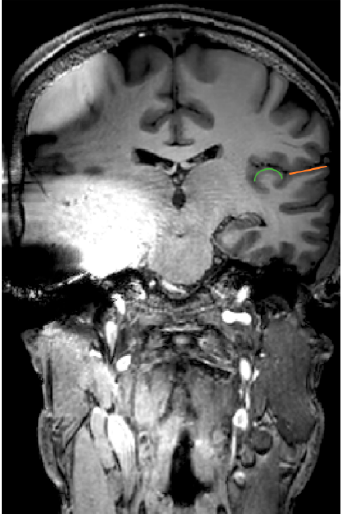
Figure 2. Visualization of the MRI artefacts caused by a unilateral cochlear implant (CI). In the left panel, the midsagittal plane has been visualized, showing large artefacts around the temporal lobe, while the inter-hemispherical corpus callosum is not hampered. The right panel shows an axial slice with extensive MRI artefacts.